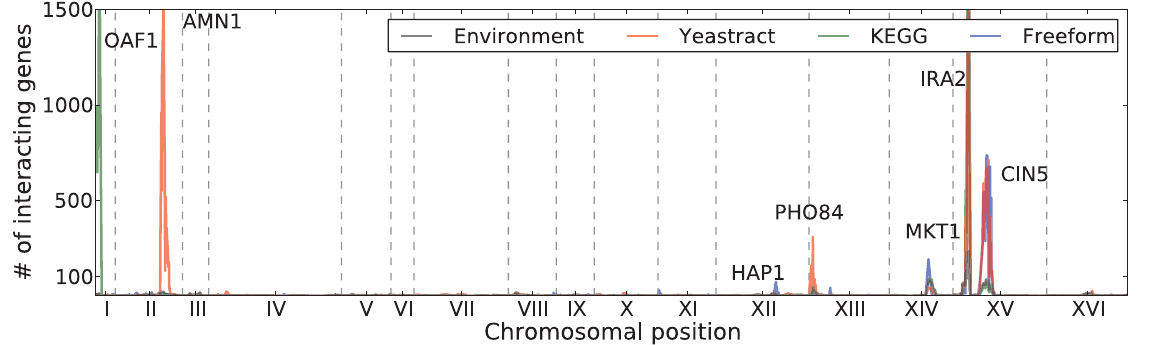
Figure 3. Number of genes affected by a genotype-factor interaction for each locus for Yeastract factors (blue), KEGG factors (red), freeform factors (green), and environment